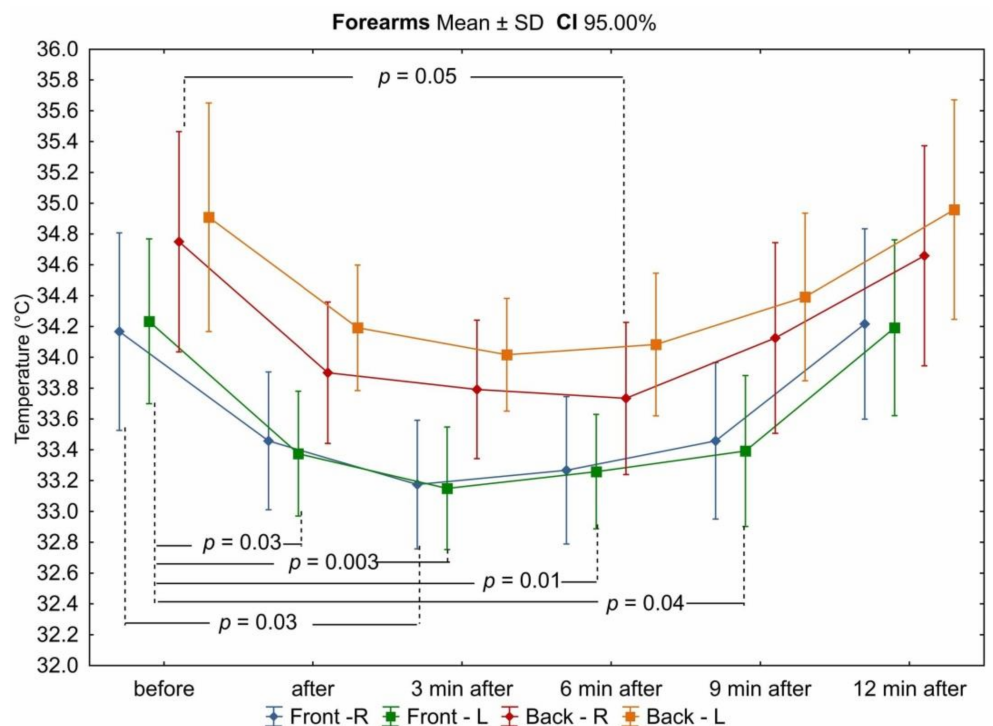
Figure 4. Dynamics of changes in the mean values of the surface temperature of the forearms during subsequent measure- ment points before and after the exercise test. Legend: test probability level determination for Tukey’s RIR post hoc tests. Data are expressed as mean with standard deviation.